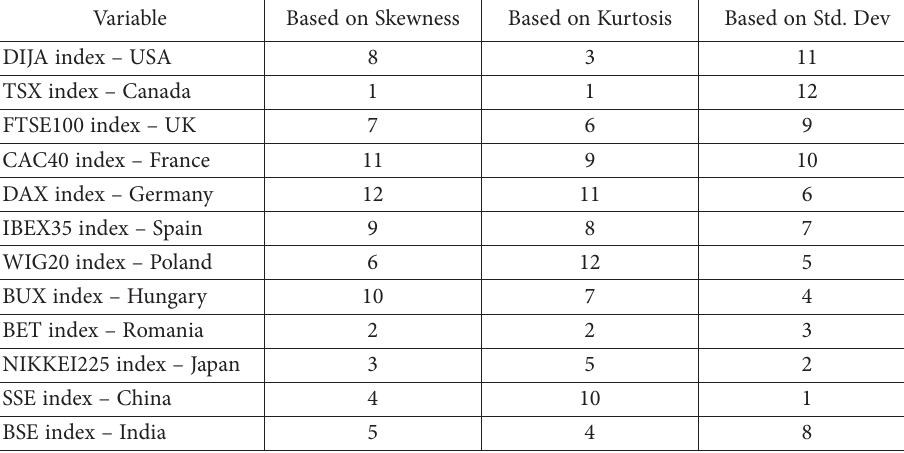
Table 2. Normality ranking (source: author’s